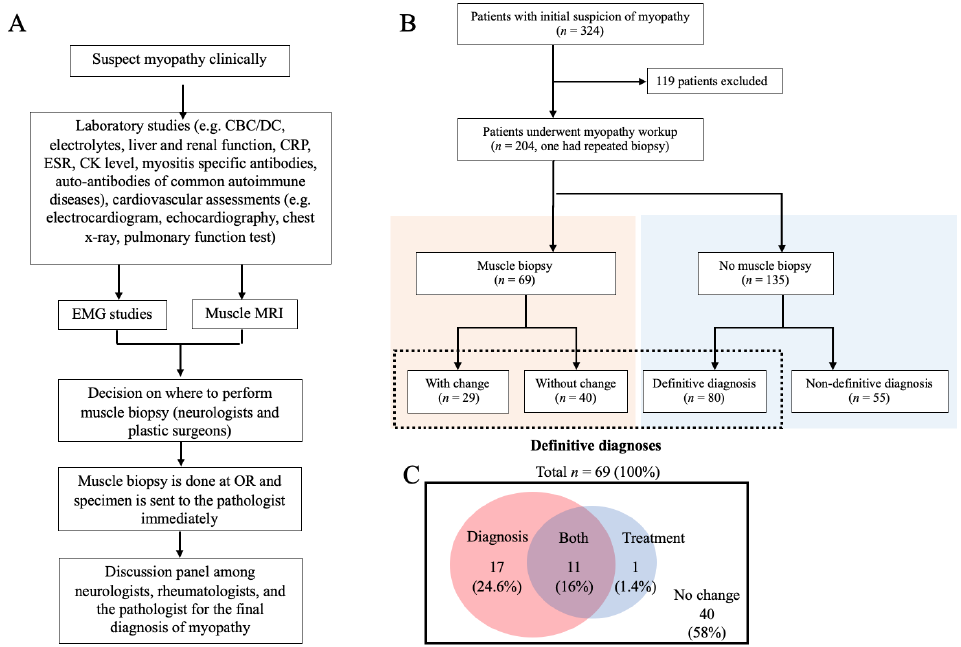
Figure 1. ( A ) A flowchart of the standardized diagnostic workup for clinically suspected myopathy at National Cheng Kung University Hospital. CBC, complete blood count; DC, differential count; CRP, C-reactive protein; ESR, erythrocyte sedimentation rate; CK, creatine kinase; EMG, electromyography; MRI, magnetic resonance imaging; OR, operating room. ( B ) A flowchart for patients with initial suspicion of myopathy between 1 January 2018 and 25 October 2021. One patient had repeated biopsy, 119 patients who did not have final diagnosis of myopathy or <18 years old were excluded. Finally, 204 patients who underwent comprehensive diagnostic workup for myopathy were classified into two groups according to muscle biopsy. The orange rectangle represented patients underwent muscle biopsy. The blue rectangle represented patients who did not have muscle biopsy. 1 patient was excluded from the biopsy group because of repeated biopsy. A total number of 69 patients were further classified into the group with change and the group without change. The patients who had a final definitive diagnosis were included in the rectangle with dotted lines. n , number of patients; EMR, electronic medical record. ( C ) A Venn diagram for the distribution of patients in change of treatment, change of diagnosis, and change of both diagnosis and treatment. Numbers represent the numbers of the patients